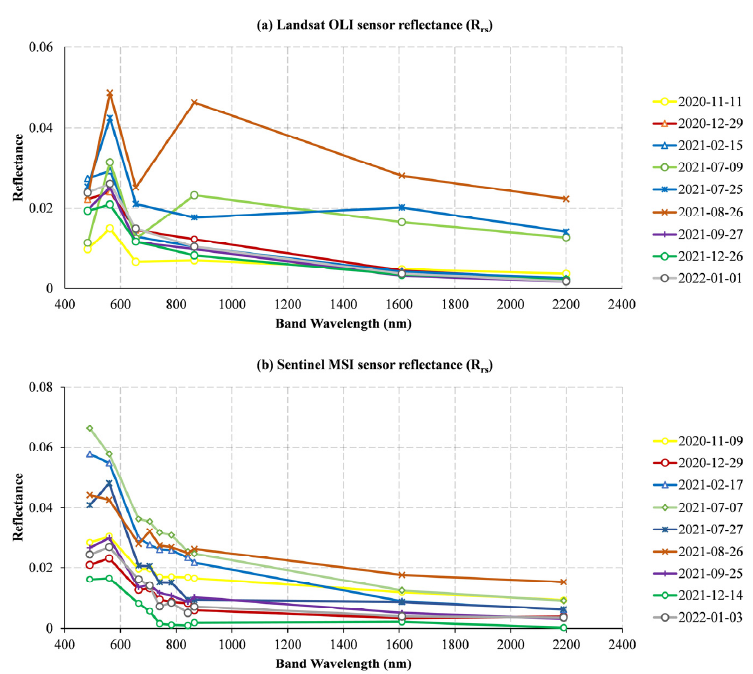
Figure 3. Reflectance variation in different bands for ( a ) Landsat OLI data and ( b ) Sentinel MSI data.